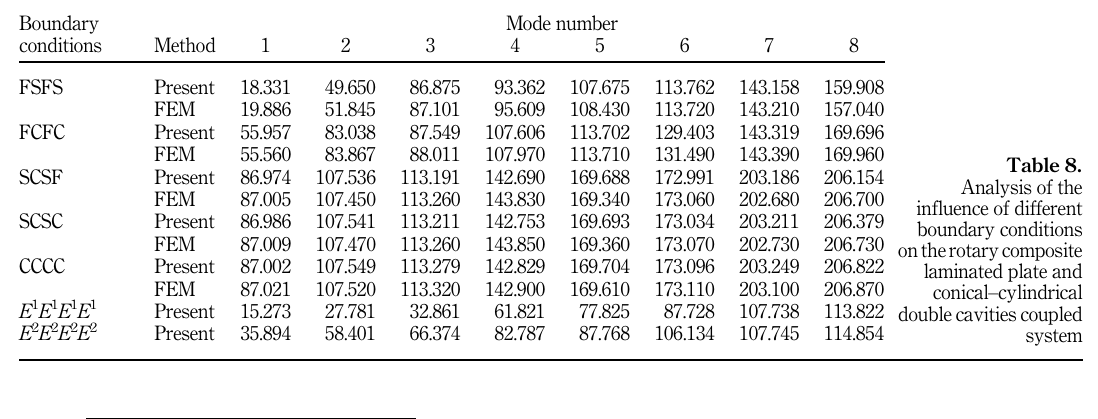
Figure 7. The variation curve of